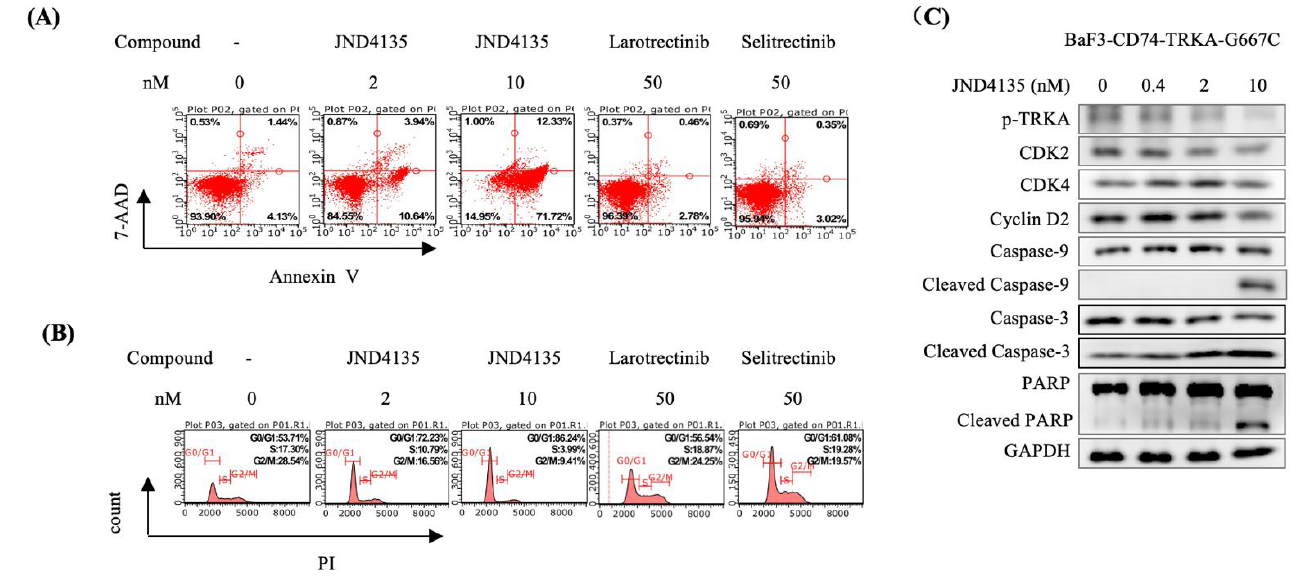
Figure 3. JND4135 induces apoptosis and G0/G1 cell cycle phase arrest in BaF3-TRKA-G667C cells. ( A ) JND4135 induces apoptosis in BaF3-CD74-TRKA-G667C cells. Cells were treated with indicated compounds for 48 h before Annexin V and 7-AAD co-staining. ( B ) JND4135 induces G0/G1 cell cycle arrest in BaF3-CD74-TRKA-G667C cells. Cells were treated with indicated compounds for 24 h before DNA labeling by propidium iodide. ( C ) The effect of JND4135 on the expression of p-TRKA, CDK2, CDK4, Cyclin D2, Caspase-9, Caspase-3 and PARP was tested by Western blotting. The cells